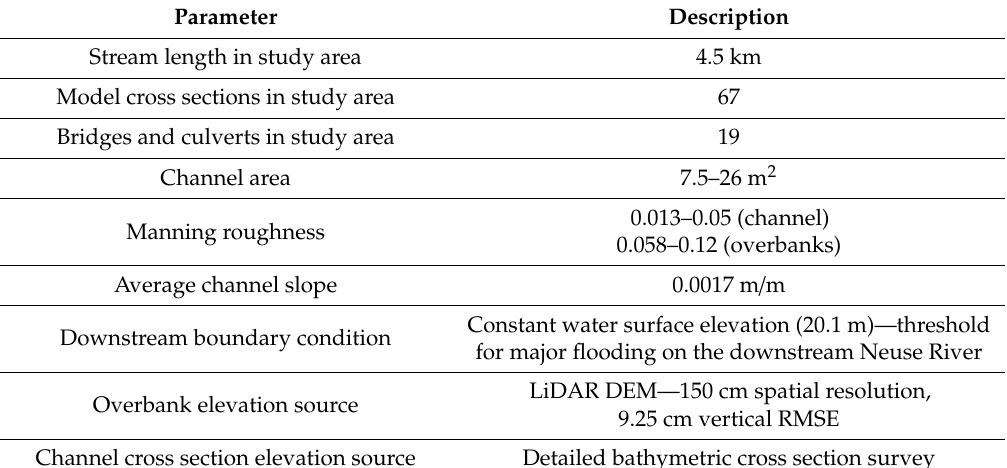
Table 1. Existing Hydrologic Engineering Center-River Analysis System (HEC-RAS) model